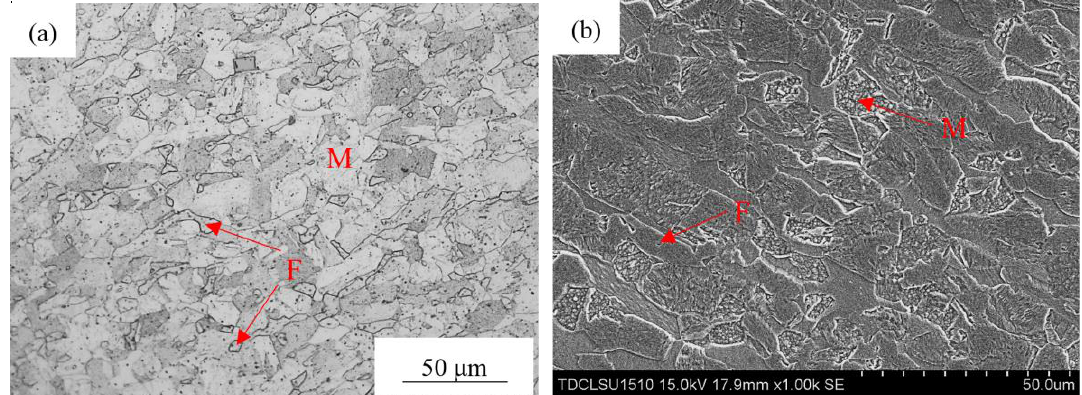
Figure 5. Continuous cooling transformation (CCT) diagram of the explored low-carbon ferritic stainless steel in this work calculated by JMatPro software.